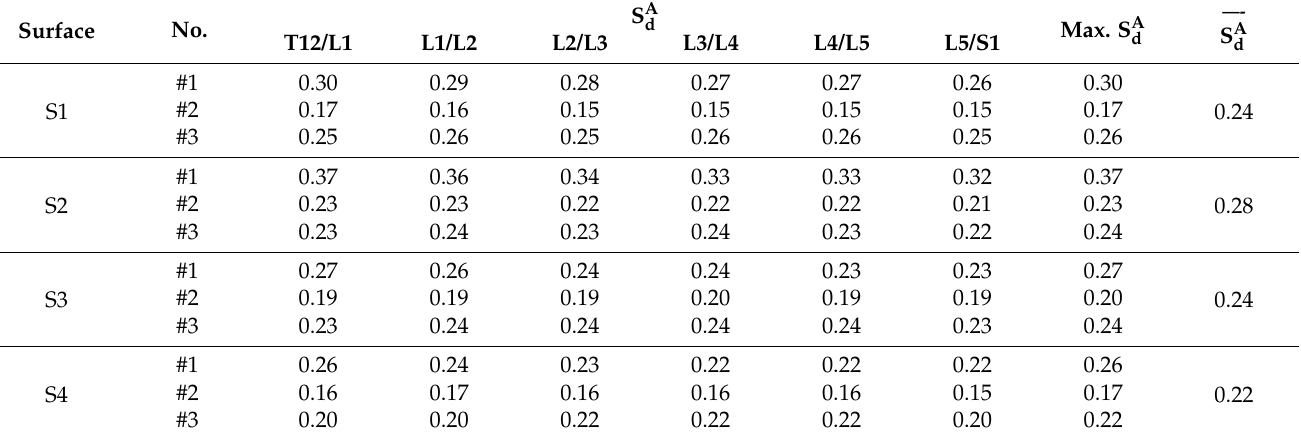
Table 9. Summary of data obtained from driver 2 according to ISO 2631-5:2018, less severe method.